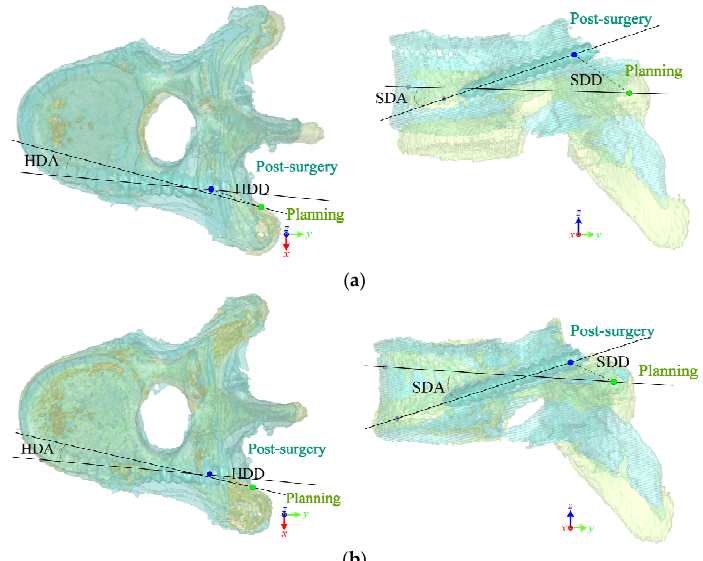
Figure 7. Comparison of planning and post-surgical screw trajectories at left screw in the T9 vertebra after superimposing via ( a ) ICP and ( b ) OSP-based contouring methods. Table 4. How the superposition results affect surgical outcome assessments in the T9 vertebra.